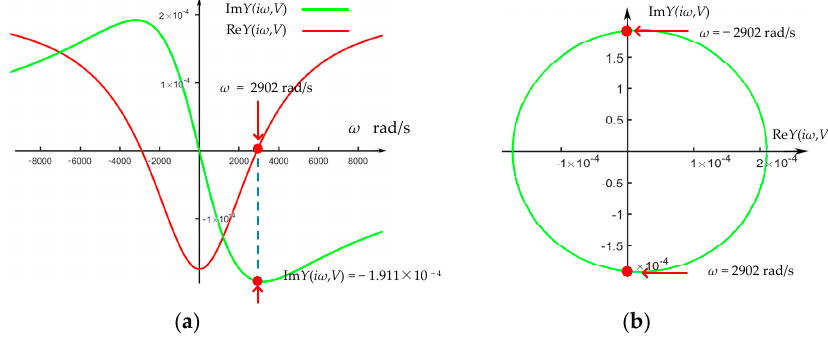
Figure 6. ( a ) Frequency response and ( b ) Nyquist diagram of the memristor at V = 0.6 V.